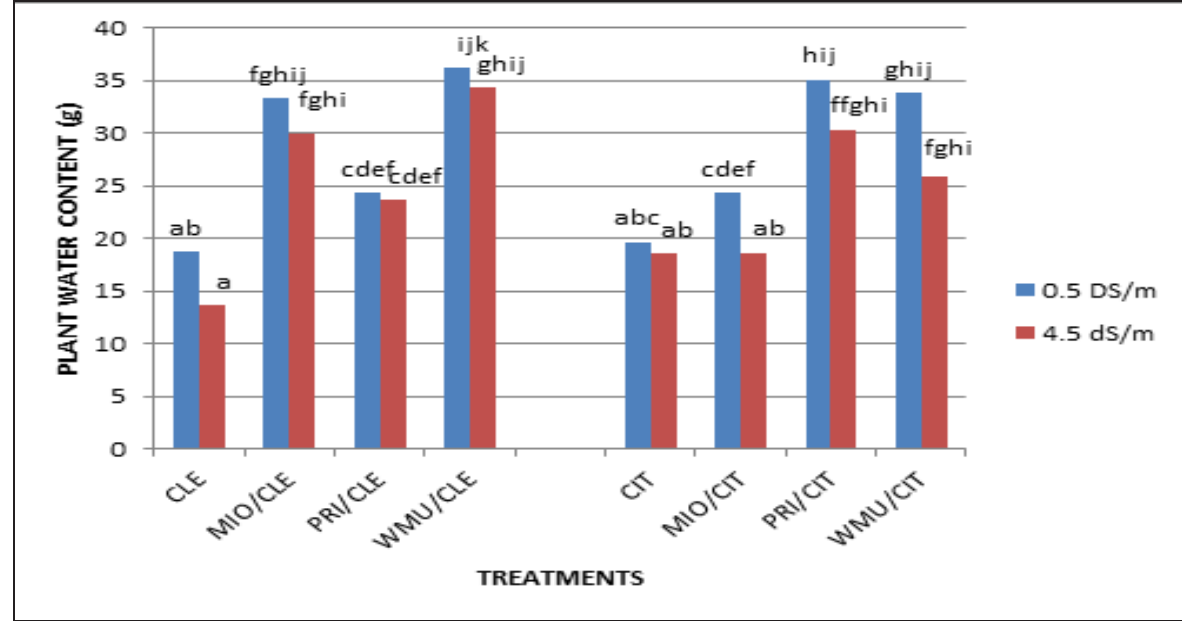
Figure 5. Effects of salt stress on plant water content (g) for each scion/rootstock combination at 90 days. *CLE (Cleopatra), MIO (Mihowase), PRI (Primosole), WMU (W. Murcott), CIT (Swingle